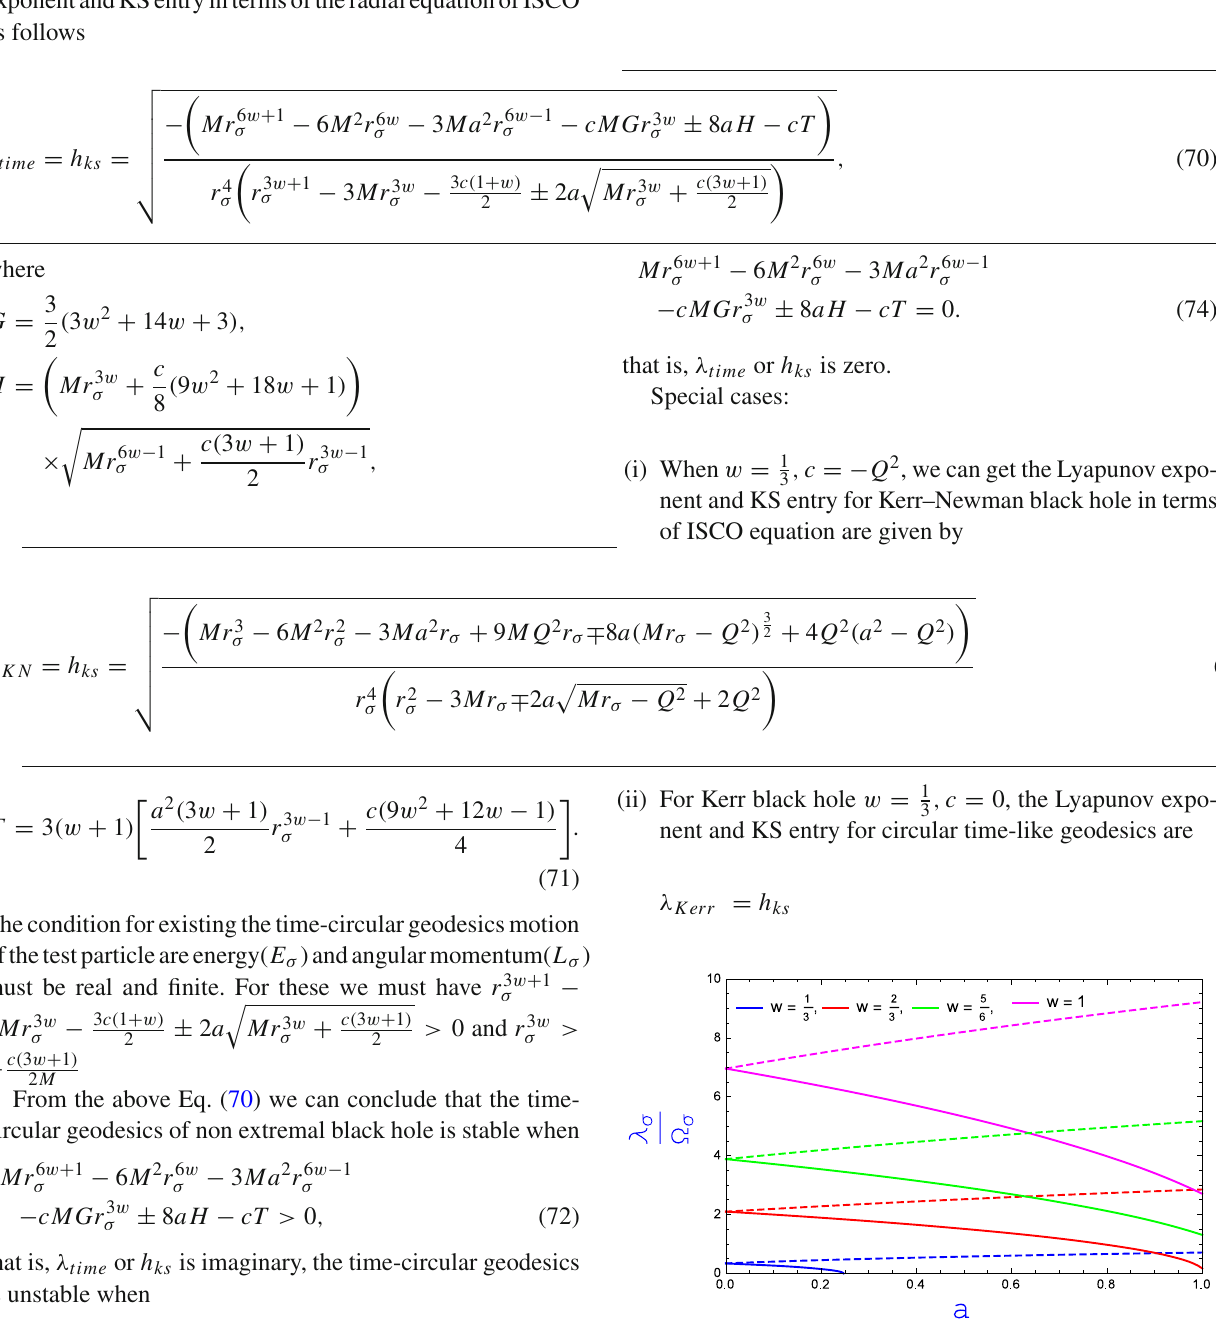
as a function of rotation σ